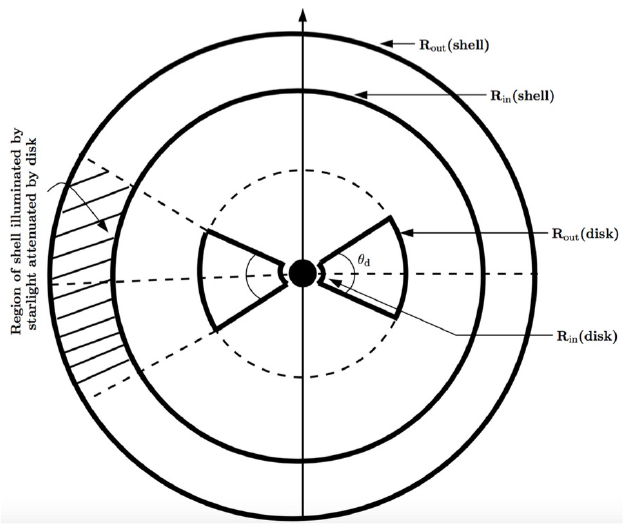
Figure 1. Illustration showing circumstellar dust geometry with an inner disk and an outer shell. R in and R out are the inner and outer radius of the disk (shell). A disk with an opening angle θ d intercepts Sin( θ d /2) (referred to as disk-fraction in this paper) of